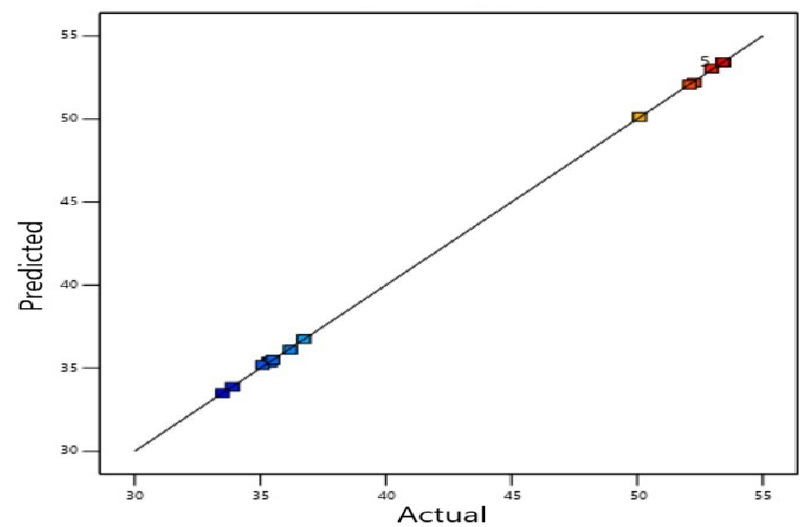
Figure 2. Plot of experimental versus predicted peak area.